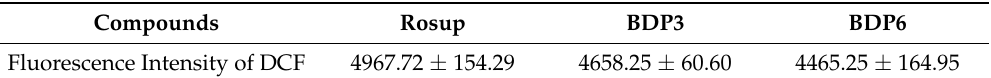
Table 3. Intracellular 2 (cid:48) ,7 (cid:48) -dichlorofluorescein (DCF) fluorescence of HepG2 cells after incubation with